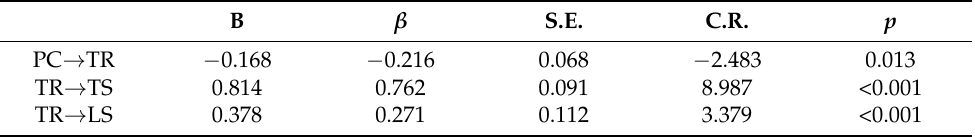
Table 5. Regression weights in the final research model. B β S.E. C.R. PC → TR − 0.168 −